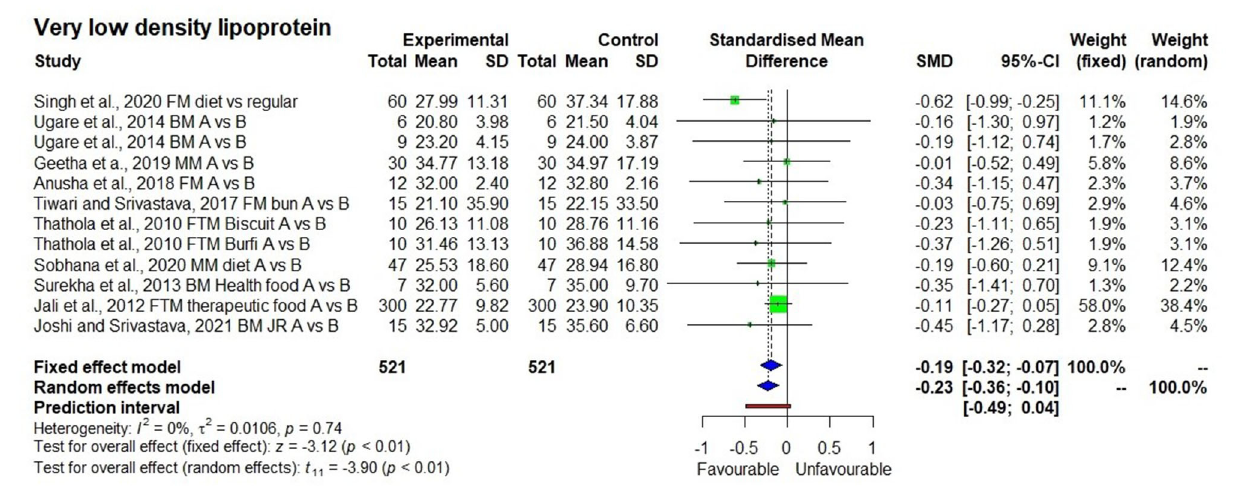
FIGURE 5 | Effect of consuming millets on very-low–density lipoprotein-cholesterol (VLDL-C) level (pre- vs. post-treatment or intervention vs. control diet).